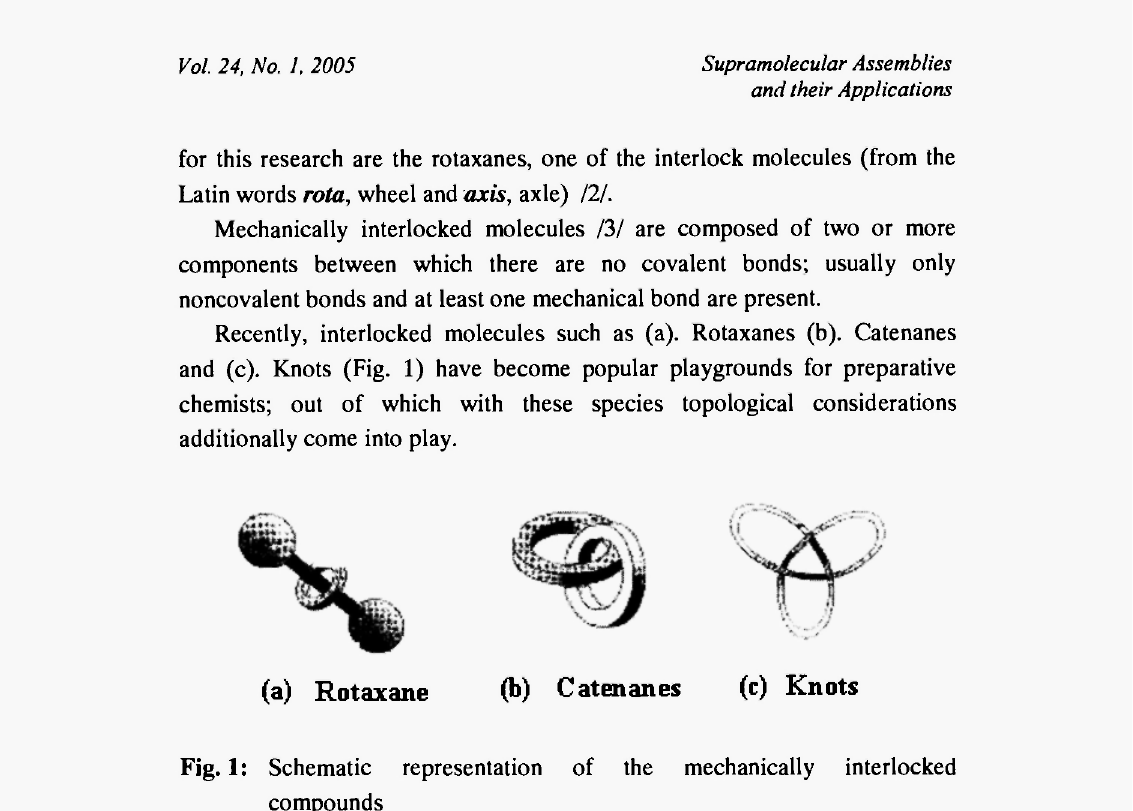
Fig. 1: Schematic representation of the mechanically interlocked compounds